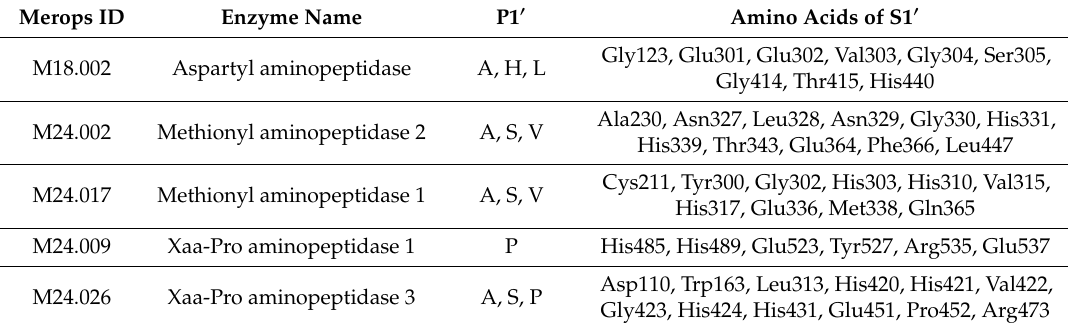
binding pocket with residues forming the